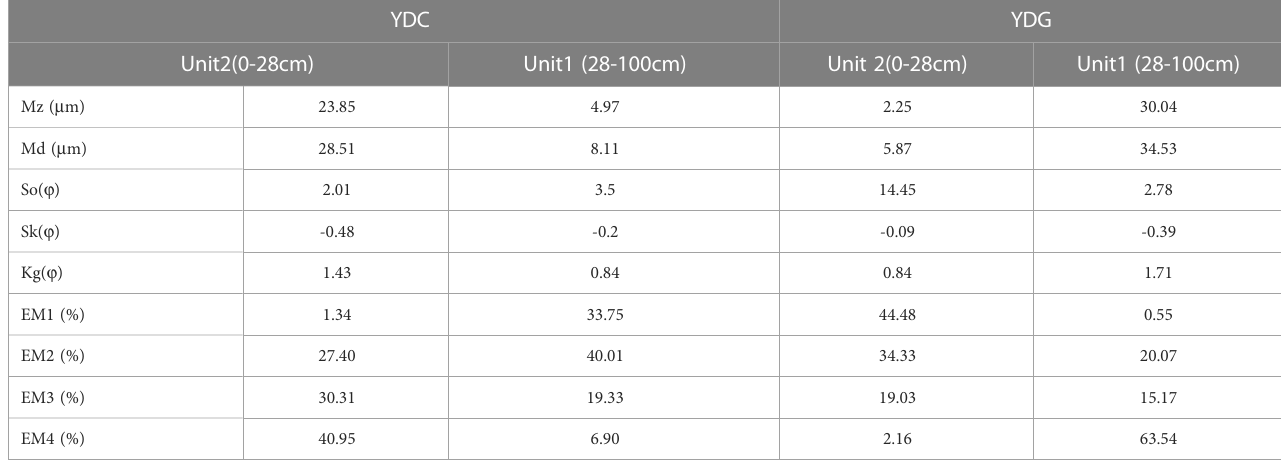
TABLE 1 Characteristics of the grain-size parameters of each stratum in the cores YDC and YDG, and comparison of the mean value of EMA results within different units.